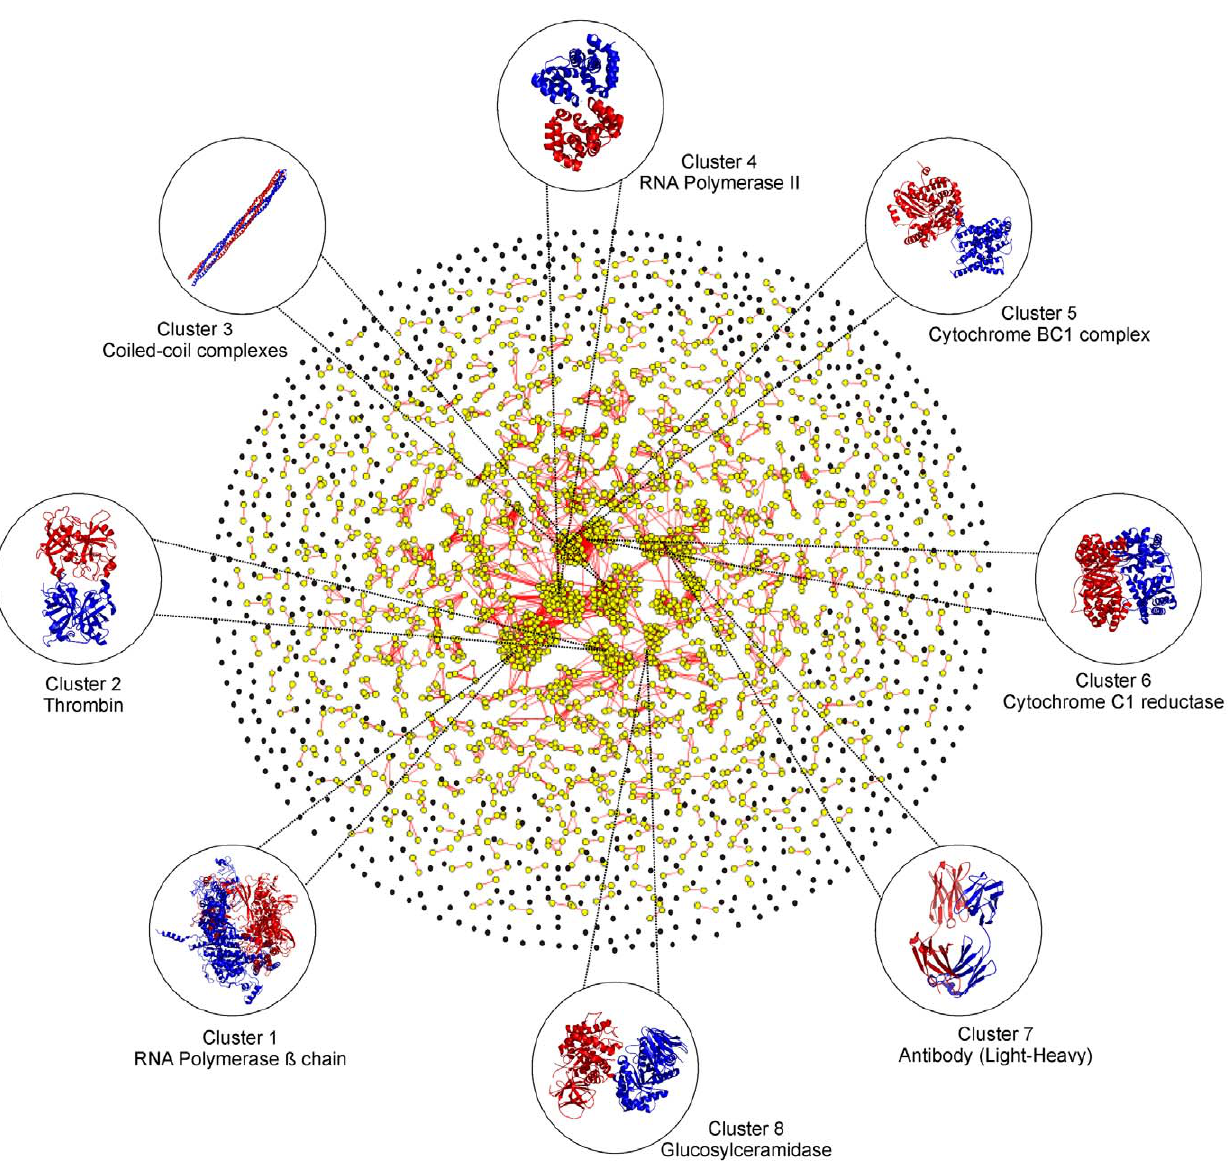
Figure 1. Graphical representation of all non-redundant protein-protein complex structures in the PDB. Each node represents a known complex structure and two nodes are connected by an edge if the rTM-score between the two structures is . 0.5. The orphan nodes are shown in black while nodes which are connected by at least one edge shown in yellow. Representative examples from eight largest clusters are listed together with the protein name.